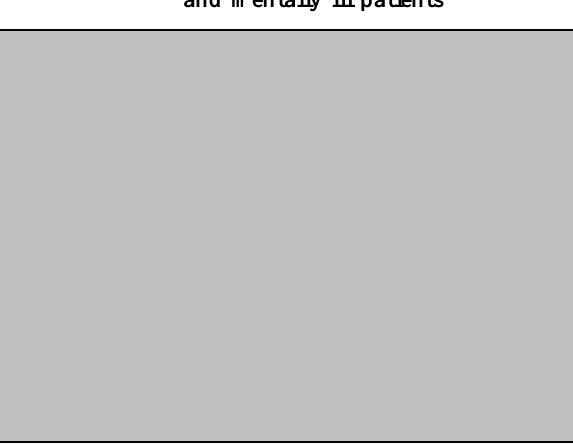
Table V : Knowledge and beliefs about